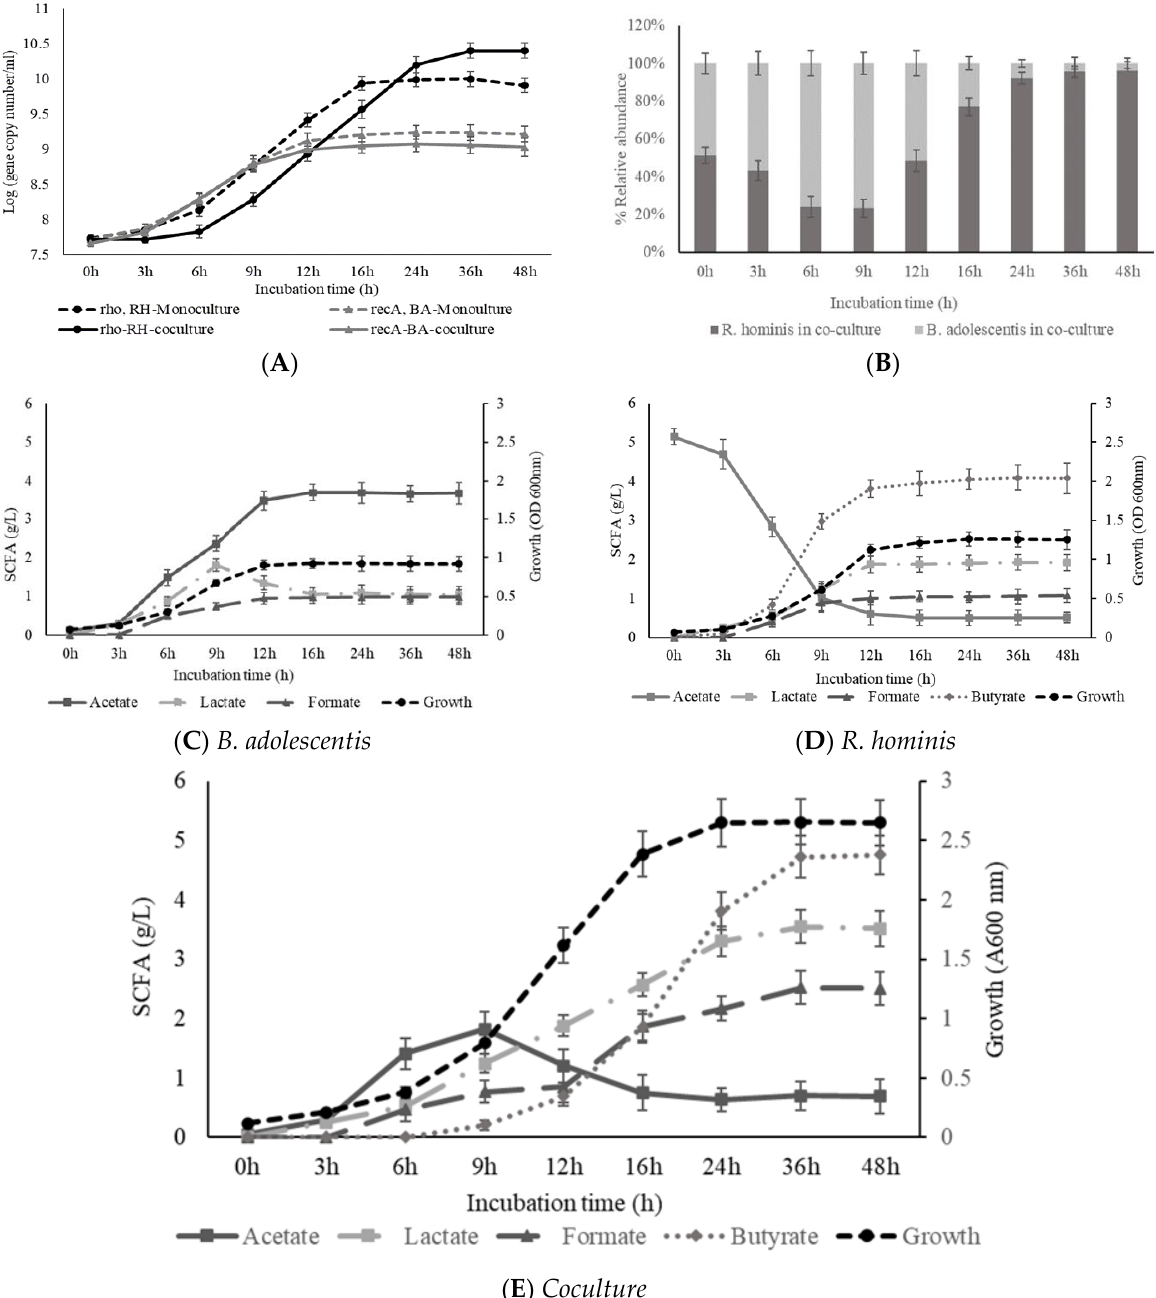
Figure 1. Growth and production of short-chain fatty acids (SCFAs) during cultivation of Bifidobac- terium adolescentis (BA) and Roseburia hominis (RH) on (galacto)- β -mannan-oligosaccharide (MOS/GMOS). ( A ) Cell concentration by qPCR-analysis for BA and RH in mono- and cocultures. ( B ) Relative strain abundance (%) in the coculture. ( C ) The BA monocultivation (in the medium for colon bacteria, MCB). ( D ) The RH monocultivation (in the modified medium for colon bacteria, mMCB). ( E ) The cocultivation of RH and BA in MCB. Rec A (for BA) and rho (for RH) genes were used as markers in the qPCR-analysis to determine the cell concentration, expressed as log (copy number/mL) in the mono- and cocultures. The sum of calculated gene-copy-number values was used to determine the relative population (%) of RH and BA in the cocultures. The optical density (OD) was determined at 600 nm. The amount of SCFAs was determined by HPLC.